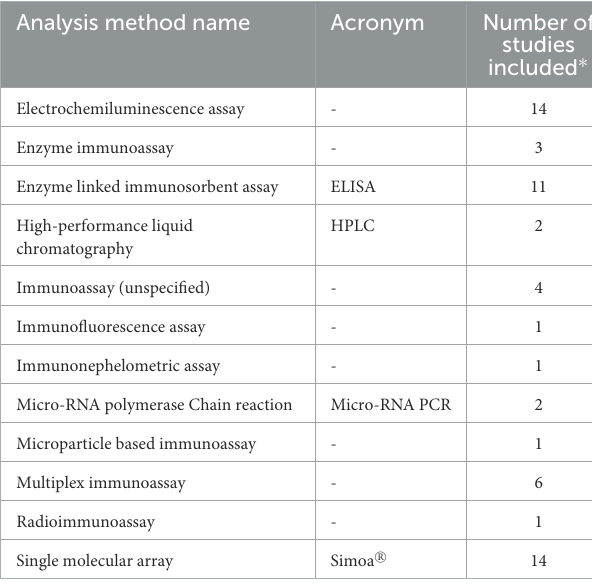
TABLE 2 Analysis methods and the number of studies in which they were